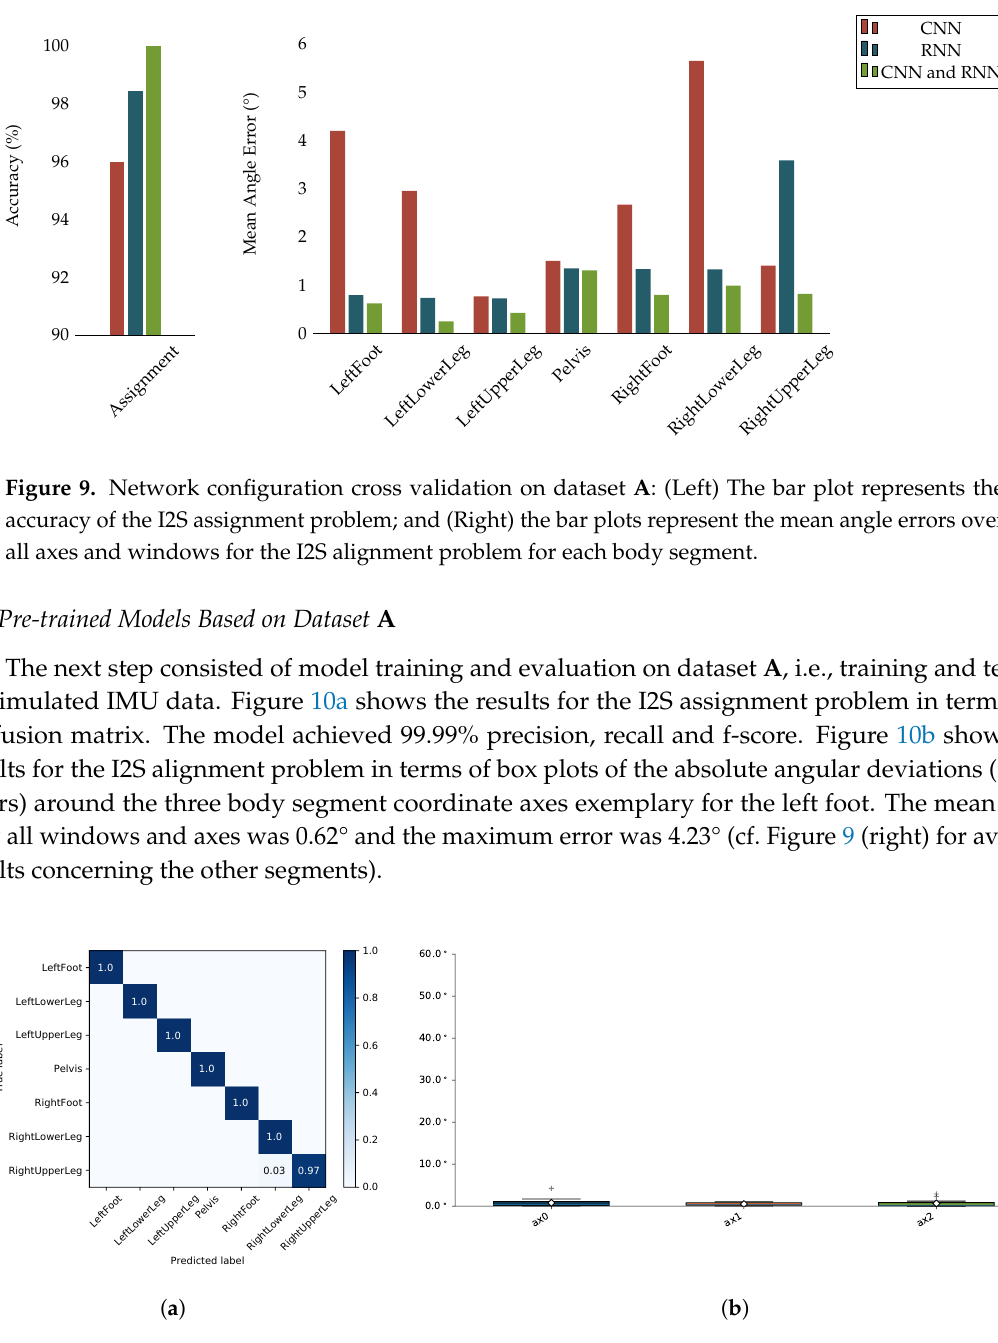
Figure 10. Evaluation results on simulated dataset A : ( a ) confusion matrix for the I2S assignment problem; and ( b ) boxplots of the angle errors around the three body segment axes for the I2S alignment problem (exemplary for the left